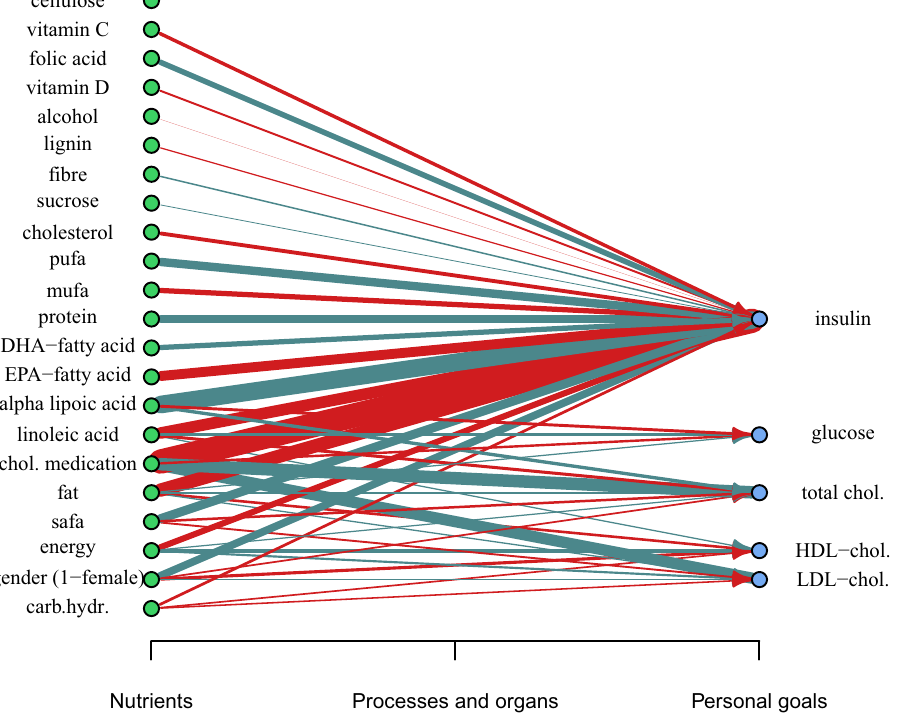
Figure 3. Visualization of the mixed-effect Bayesian network shows the general effects from nutrients ( j = 1, . . . , 22 ) to concentrations ( i = 1, . . . , 5 ). The strength of the effects from parameters by the thickness of the edge. Red edges denote the increasing effect and blue edges denote the decreasing effect. The Bayesian network corresponds to the systems biology of personalized nutrition by connecting the statistical effects of nutrients to personal goals of well-being. The goal might be, for example, reaching the reference values of the blood concentrations. The figure is plotted with iGraph package for R language (v 1.2.6, https:// igraph.